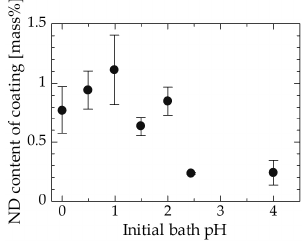
Figure 3. Relation between the initial pH of the bath and the ND content of the coating.